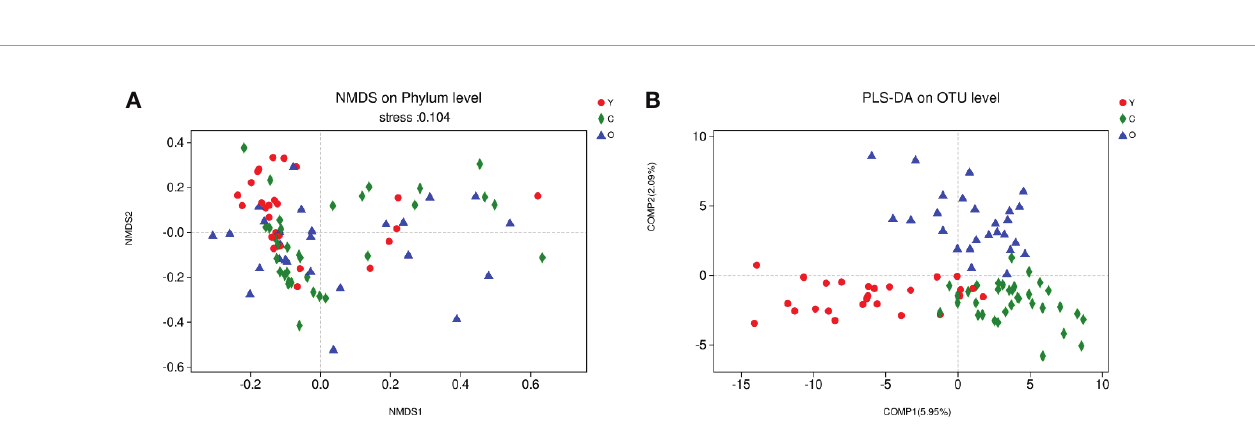
FIGURE 1 | The difference of Shannon (A) and Simpson (B) index among three groups; the bigger the Shannon index is, the more diverse the sample is, while the Simpson index is the opposite. (Y, young volunteers; O, old volunteers; C, CRC patients). n.s, no signi fi cance.